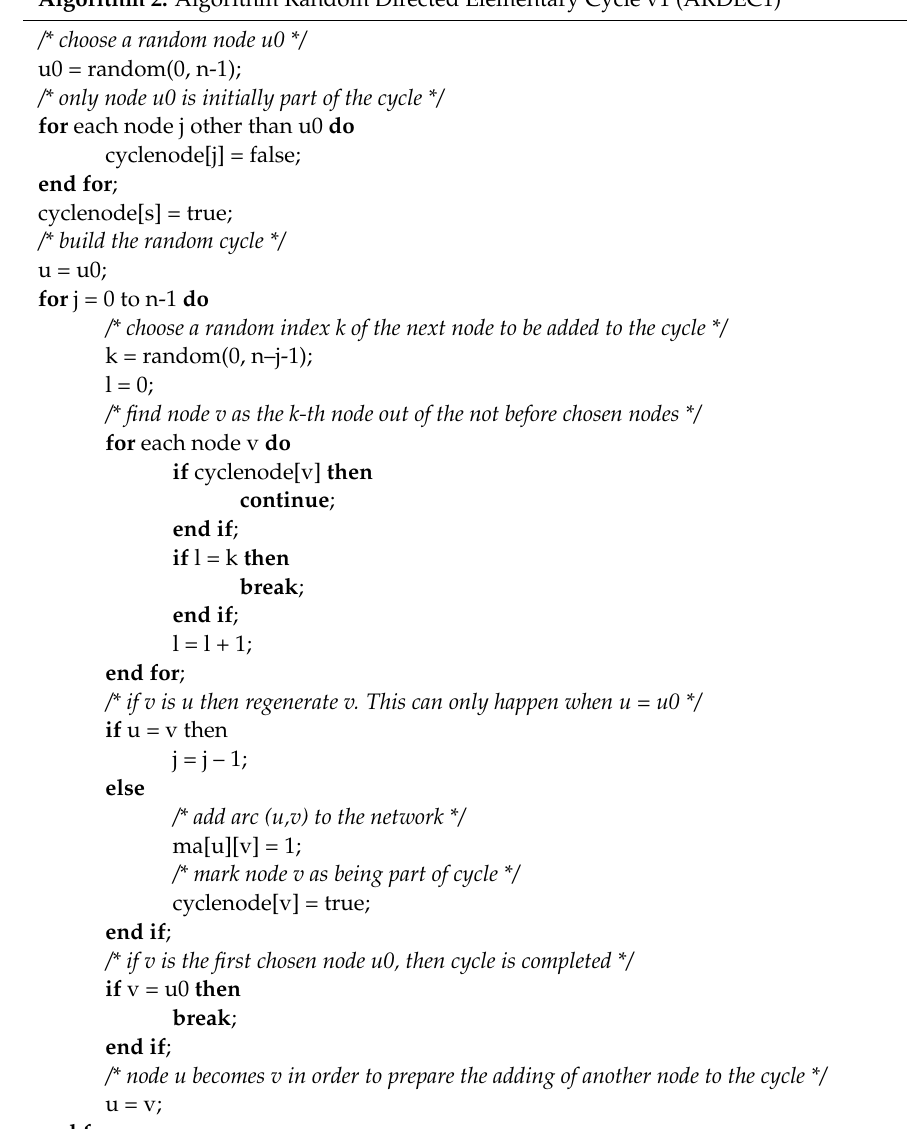
Algorithm 2. Algorithm Random Directed Elementary Cycle v1